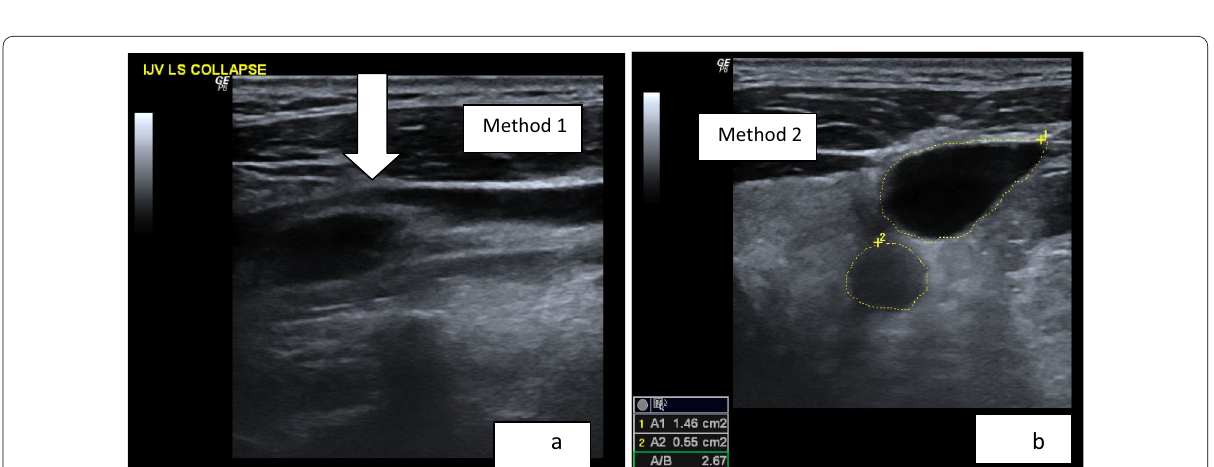
Fig. 5 Ultrasound images for a 54 years old male patient ( a ) a longitudinal ultrasound image for the collapsing point of the IJV (vertical white arrow) (method 1) and it was 13 cmH20 ( b ) transverse ultrasound image for the cross‑sectional areas (marked as dotted yellow lines by manual tracers) of the IJV ( 1.46 cm2) and the CCA area ( 0.55 cm2) and the ratio ( 2.67) (method 2). The Invasive CVP measurement (by the catheter) was 15 = = =